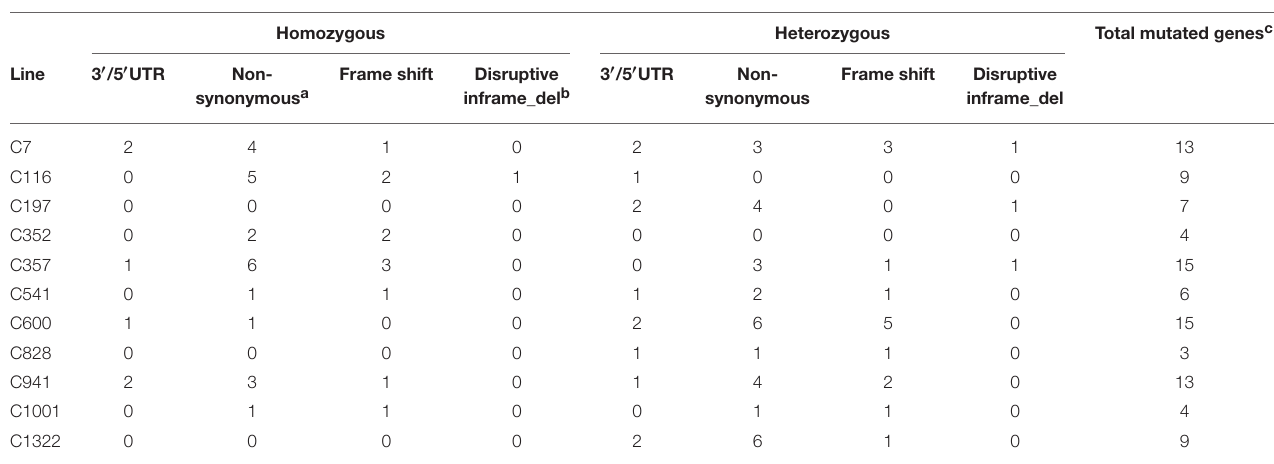
TABLE 2 | Numbers of genes predicted to occur function changes in the 11 re-sequenced